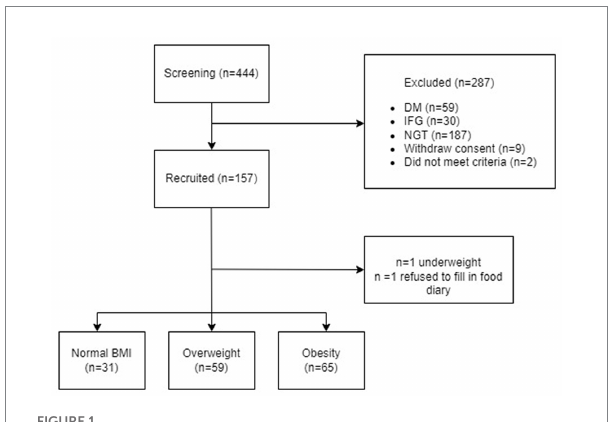
FIGURE 1 Flow chart of the study. NGT, normal glucose tolerance; IGT, Impaired glucose tolerance; DM, Diabetes